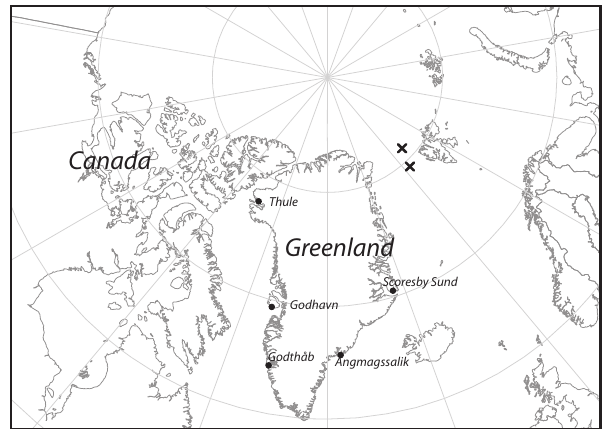
Fig. 1. Map of the study area. The northern “X” marks the studied sea ice floe position (81 ◦ N, 5 ◦ E) on 22 June and the southern “X” marks its position (80 ◦ N, 2 ◦ E) on the 30 June